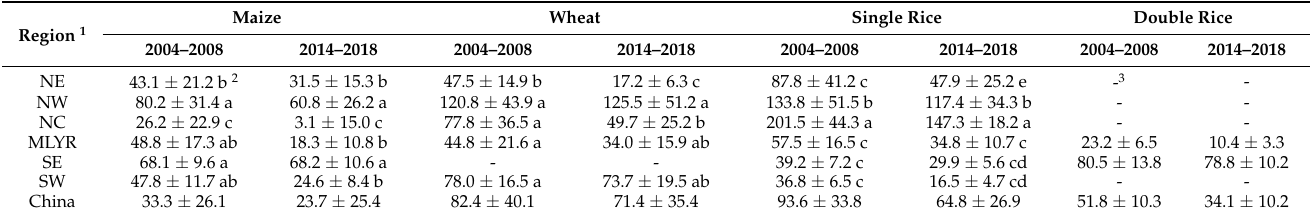
Table 1. Nitrogen (N) balance (kg N ha − 1 ) for maize, wheat, single rice and double rice between the 2004–2008 and 2014–2018 at the region and national scale in China’s farmlands, respectively.